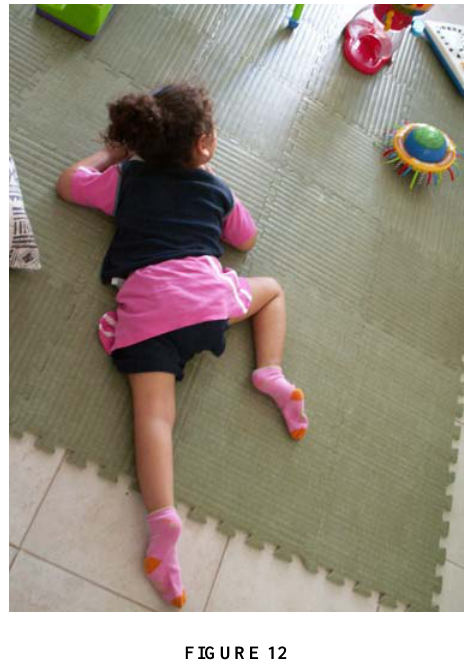
FIGURES 8–12. Different positioning equipment for management of scoliosis in